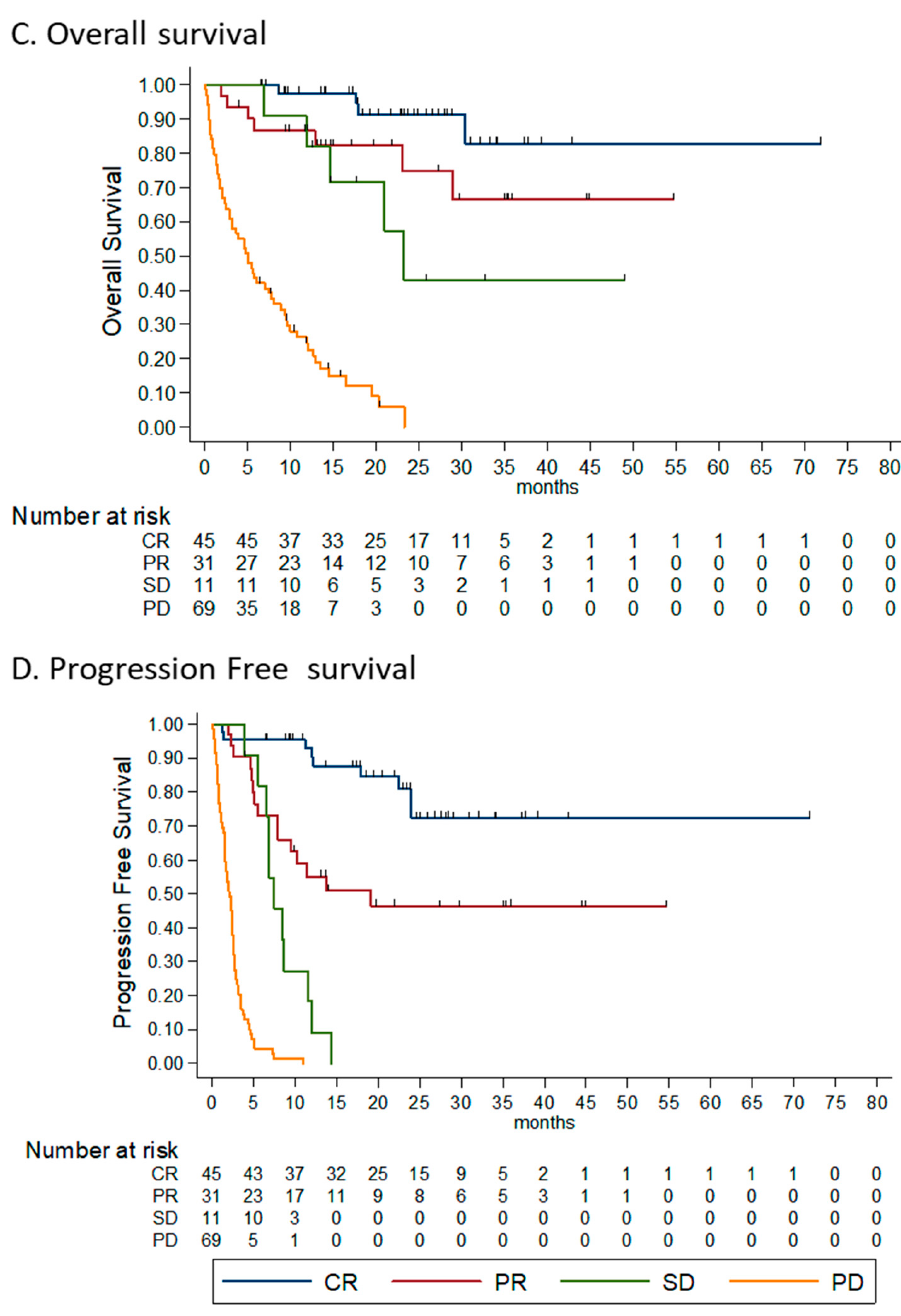
Figure 1. Kaplan-Meier survival estimates according to line of treatment and best response. ( A ) OS according to line of treatment. mOS for naïve patients—NR and 6.1 m for previously treated patients. HR for death 4.0 (95% CI 2.6–6.5, p < 0.0001). ( B ) PFS according to line of treatment. mPFS for naïve patients 12.2 m and 2.6 m for previously treated patients. HR for PFS 3.0 (95% CI 2.0–4.5, p < 0.0001). ( C ) OS according to best response to the treatment. Mos–NR, NR, 21 m and 4.8 m for CR, PR, SD and PD patients, respectively. The HR for death for patients with PR was 3.06 (95% CI 0.89–10.46 p = 0.075) compared CR patients. For patients with SD as best response, HR was 5.79 (95% CI 1.55–21.62, p = 0.009) compared to CR patients. ( D ) PFS according to best response to the treatment. mPFS was NR, 19.1 m, 7.5 m and 2.1 m for CR, PR, SD and PD patients, respectively. HR for PFS for patients with PR was 3.45 (95% CI 1.5–7.9, p = 0.035) compared to CR patients. For patients with SD as best response, HR for PFS was 11.62 (95% CI 4.57–29.55, p < 0.0001) compared to CR patients. OS—overall survival,